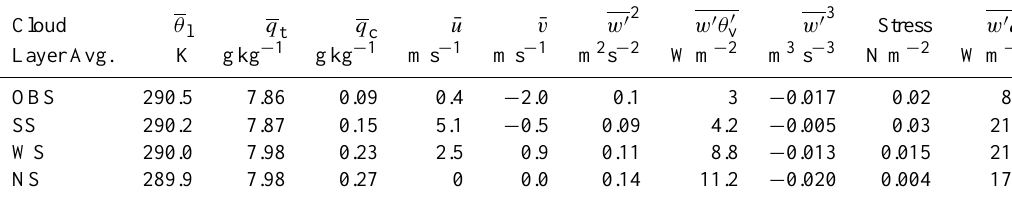
Table 2. Comparison between LES and observation results averaged in the cloud layer. Cloud